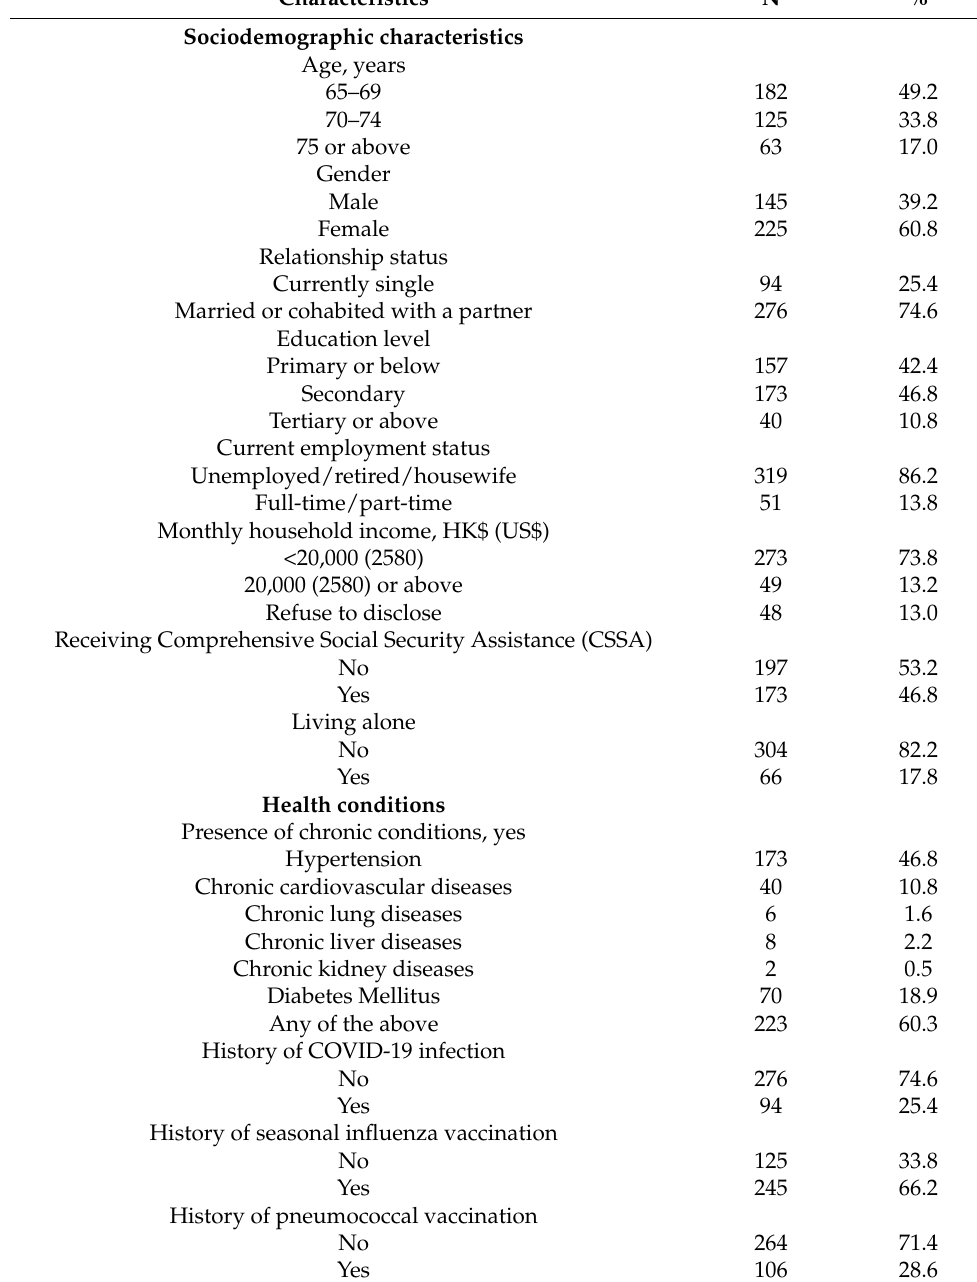
Table 1. Background characteristics of the